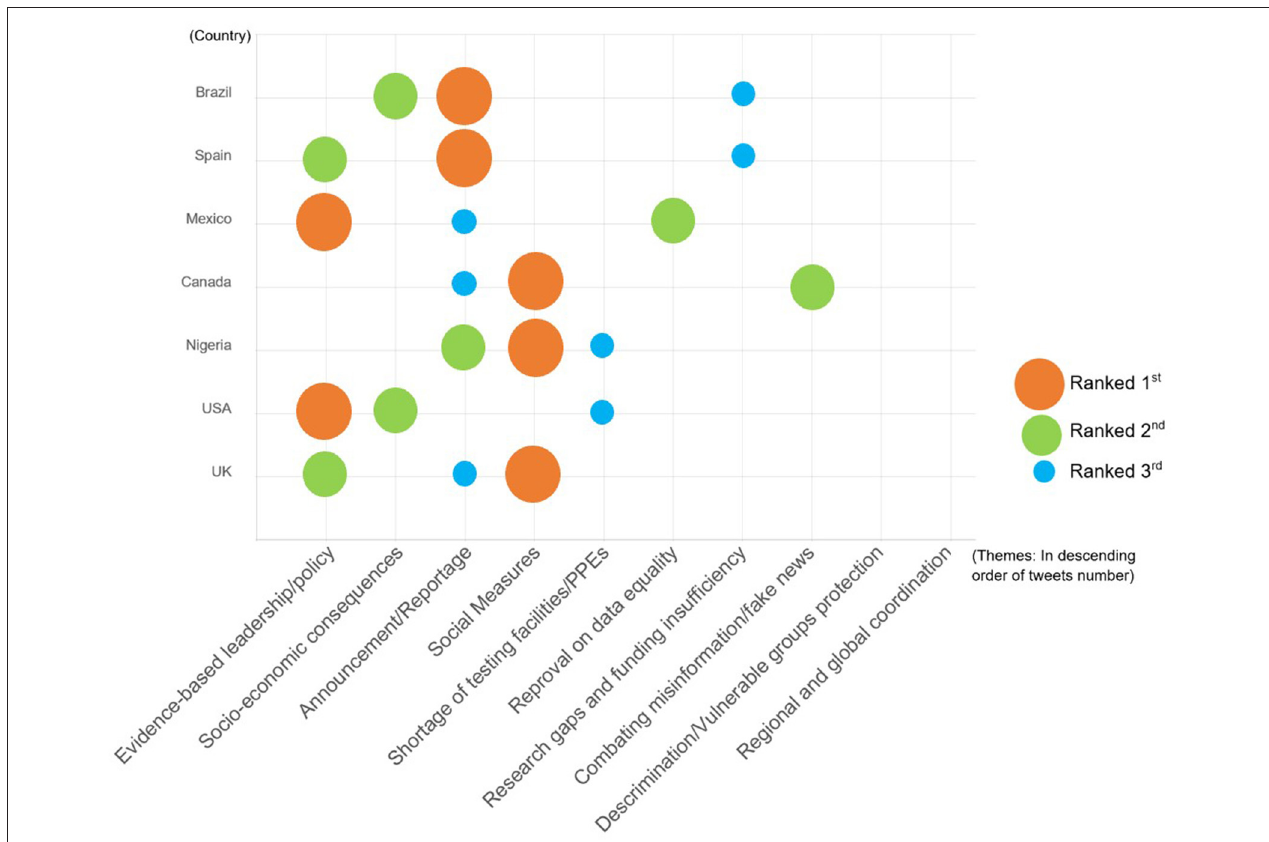
FIGURE 6 | Top three themes per